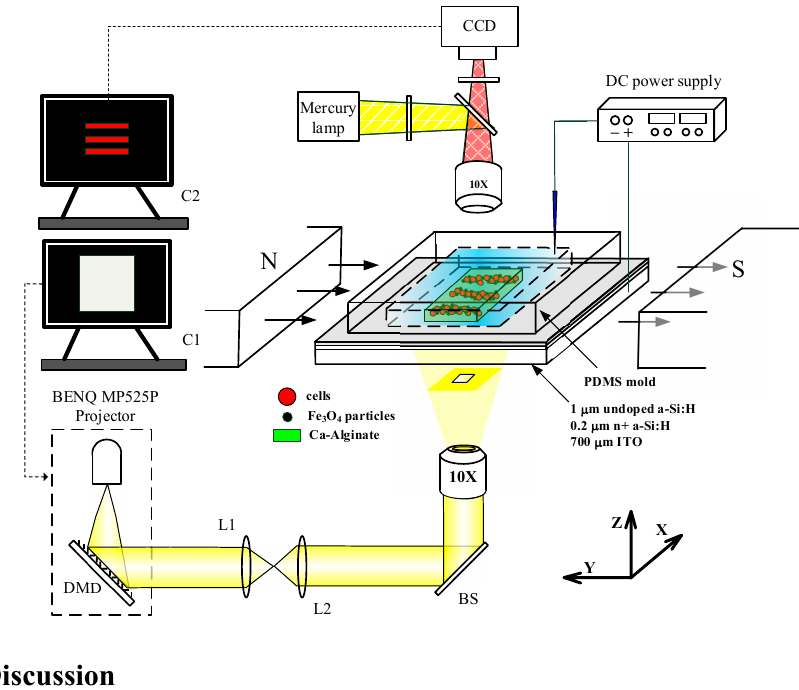
Figure 2. Schematic diagram of an experimental setup for a light-addressed electrolytic system for magnetically-guided cells encapsulated in alginate hydrogels using a modified commercial DMD projector. A modified commercial DMD projector that is equipped with a mercury lamp unit as the light source. L1 and L2: focus lens; BS: beam